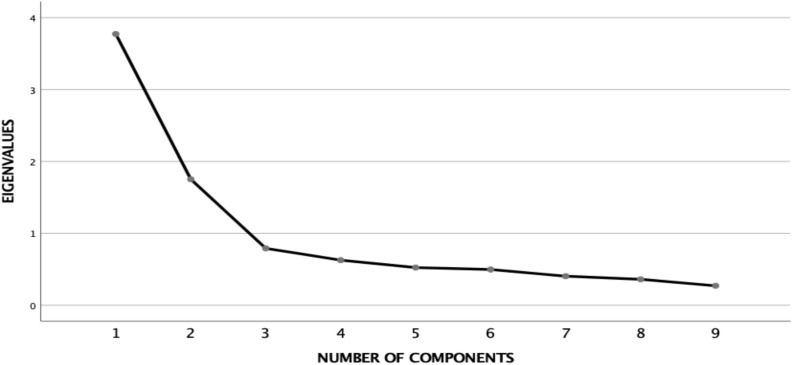
Sedimentation graph.